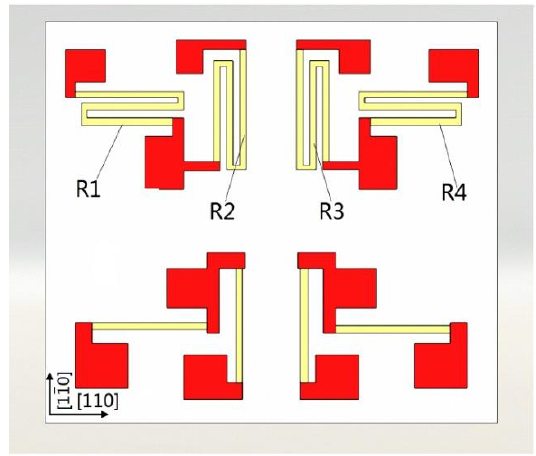
Figure 5. Schematic view of the designed MEMS strain gauge.